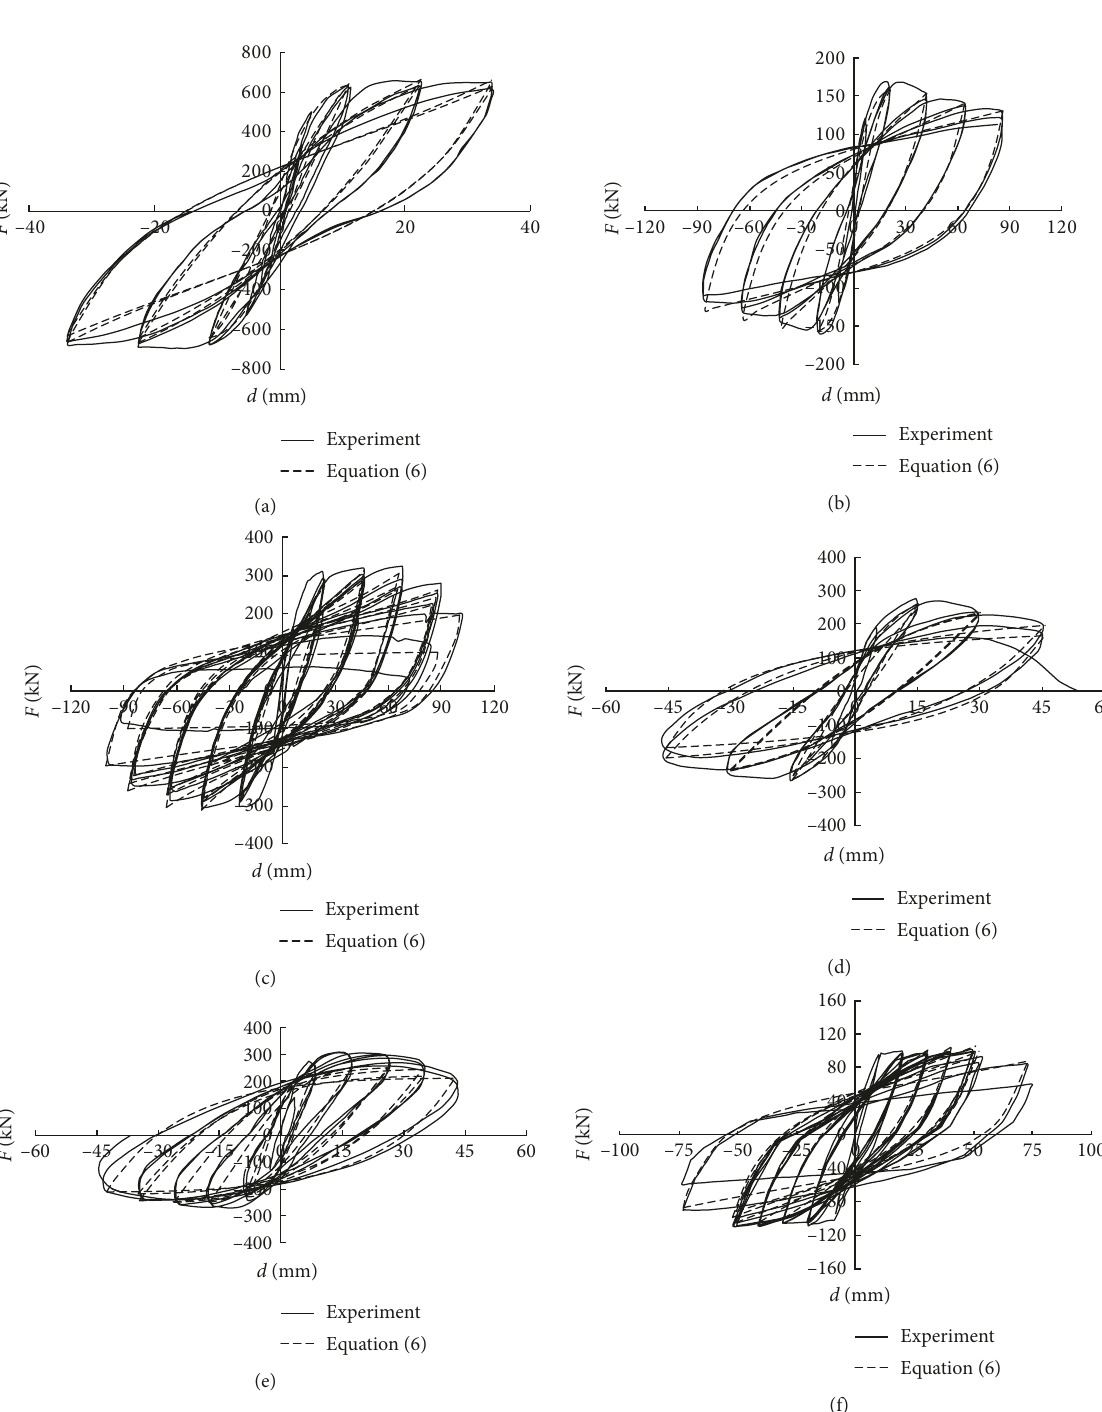
Figure 3: Comparison of hysteretic loops between the test and that predicted by (6). (a) Gill et al. (No. 1). (b) Tanaka and Park (No. 2). (c) Saatcioglu and Ozcebe (U4). (d) Soesianawati et al. (No. 3). (e) Watson and Park (No. 9). (f) Ohno and Nishioka